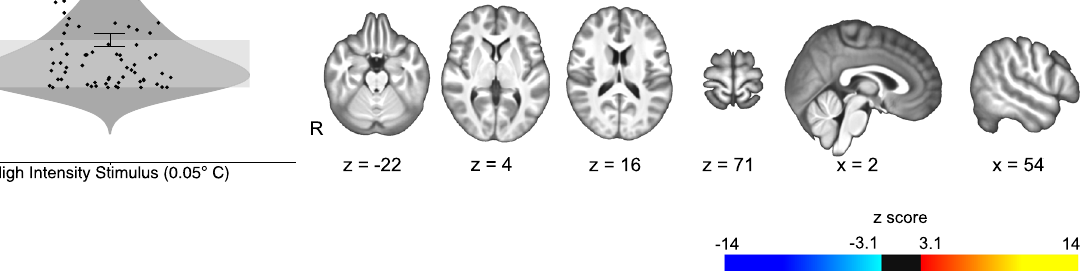
Fig. 3 Univariate analysis revealed widespread brain activation associated with high intensity cold stimulation (0.5 °C), but no relationship with perceived pain intensity. A Ratings of pain intensity in response to high intensity cold stimuli ranged from 0 to 6.82. Mean and standard error represented by the bar plot. n = 73 participants. B Effect of high intensity cold stimulation on brain activation. Areas of increased activation included the putamen (Put), caudate nucleus (Cau), secondary somatosensory cortex (SII), insula (Ins), anterior cingulate cortex (ACC), and dorsolateral prefrontal cortex (DLPFC). Areas of decreased activation included bilateral amygdala and hippocampus (Amy/Hippo), primary somatosensory cortex (SI), posterior cingulate cortex (PCC) and precuneus (Prec). C There was no relationship between perceived pain intensity and brain activation associated with high intensity cold stimulation. Source data are provided as an xlsx Source Data fi le and activation maps are available on